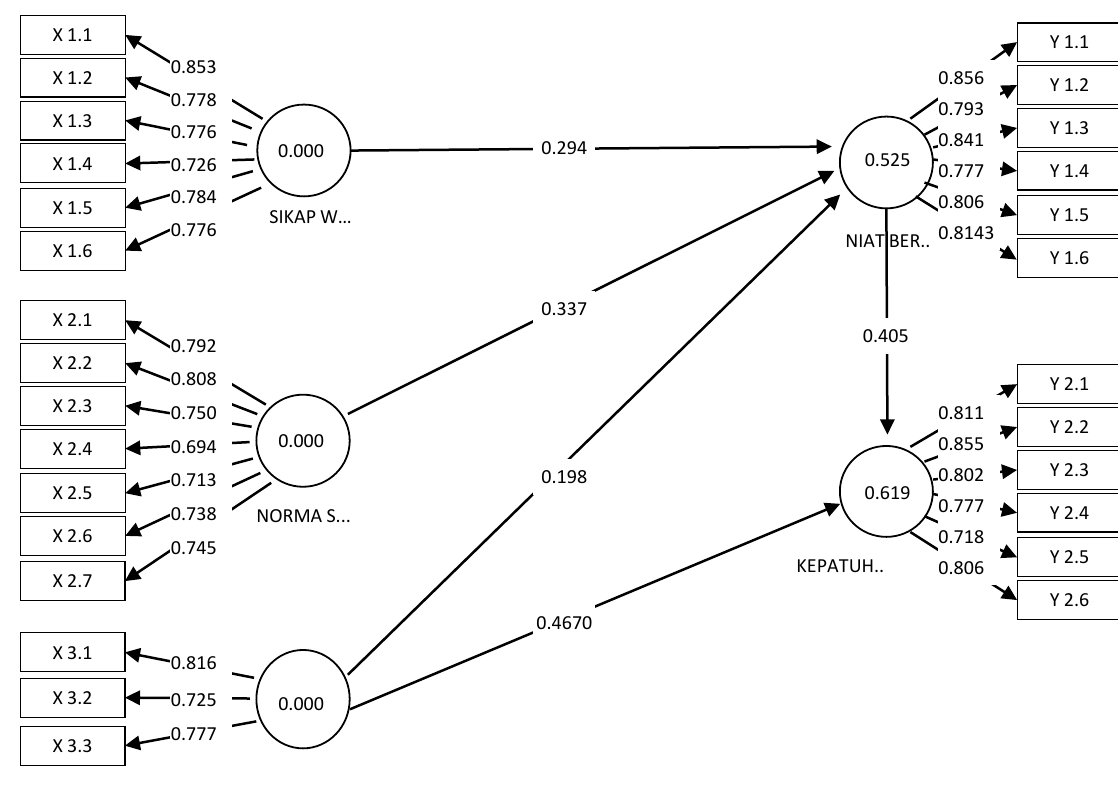
Figure 3. Structural model direct and